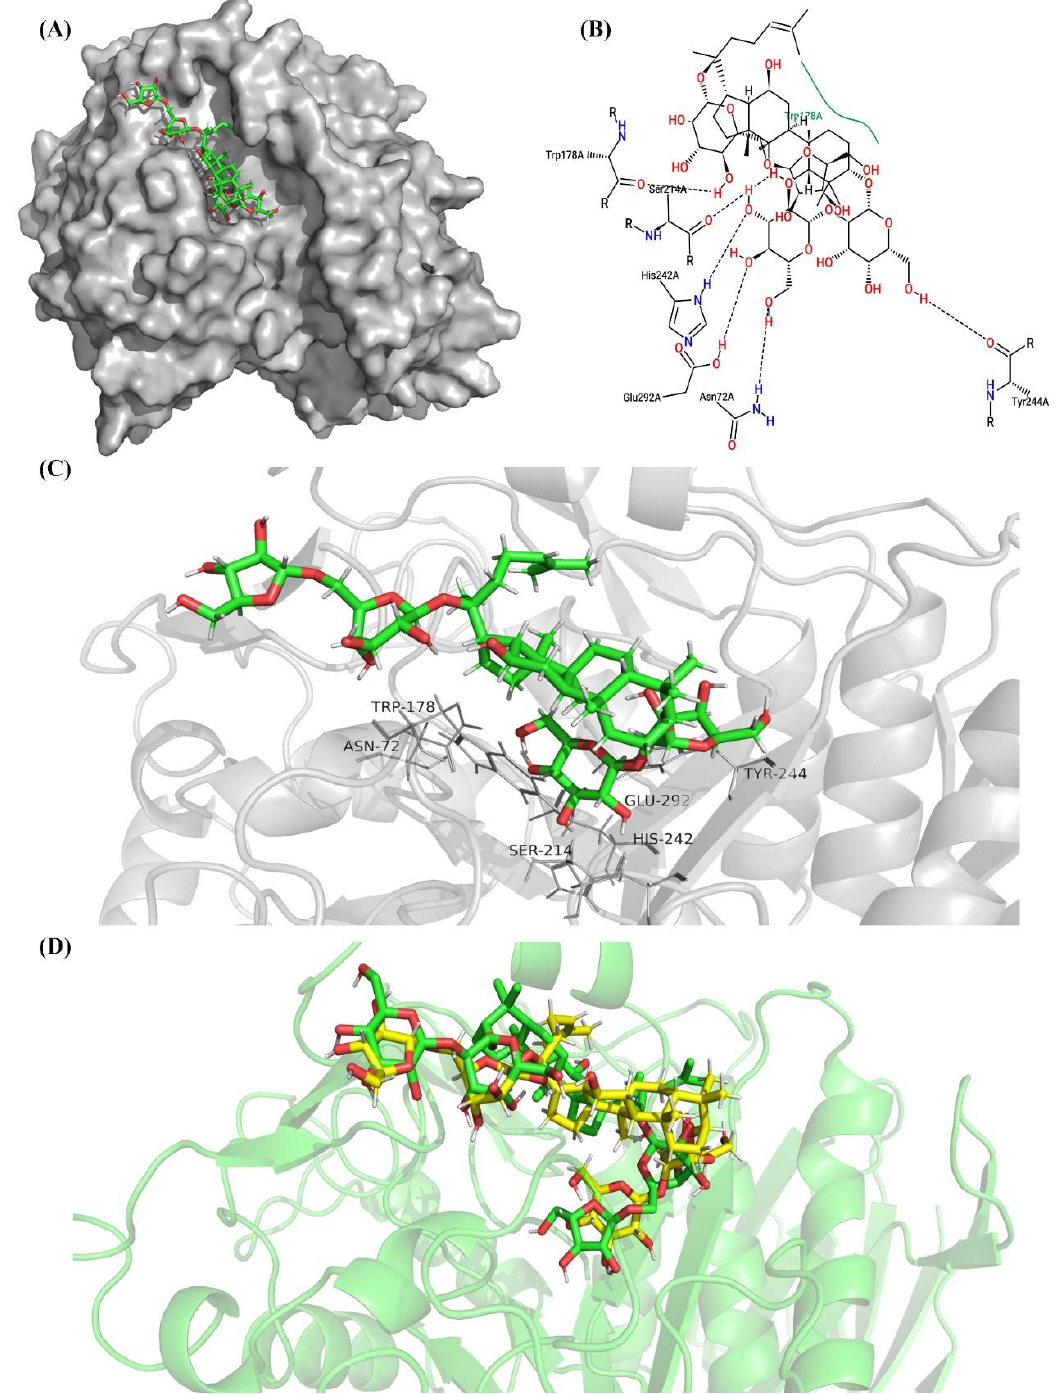
Figure 11. Molecular docking of ginsenoside Rc in the cluster 5 model of BsAbfA (with the maximum docking score). ( A ) Stereoview of the predicted binding of BsAbfA by initial docking. ( B ) Key residues interacting with ginsenoside Rc. ( C ) The binding form and type of key residues with ginsenoside Rc. The dashed line represents hydrogen bond, and the green line represents hydrophobic interaction. ( D ) Docking positions of cluster 5 compared to cluster 1. Ginsenoside Rc represented as yellow (cluster 5) and green (cluster 1) stick model inside a solvent excluded surface (SES) colored by elements.